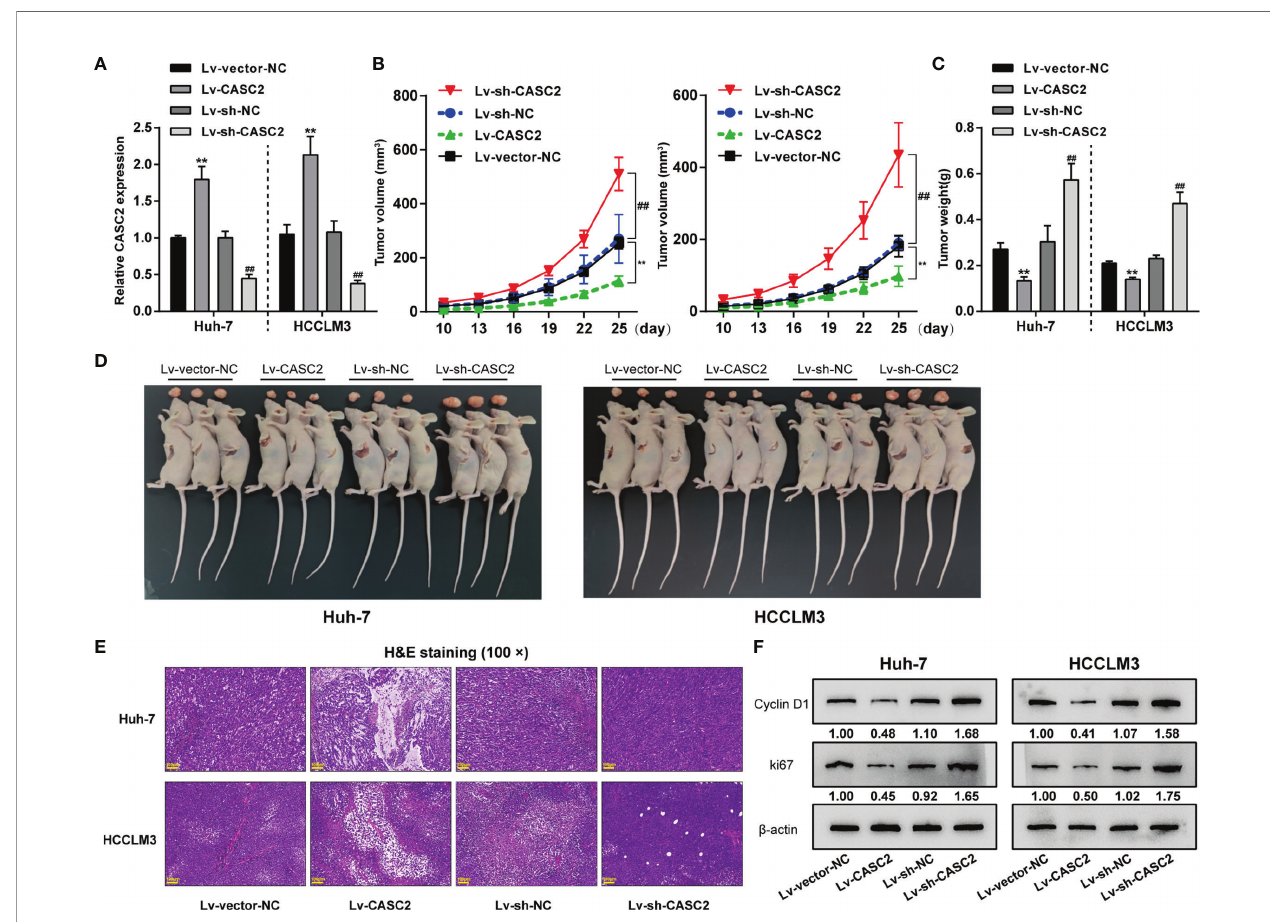
FIGURE 2 | In vivo effects of lncRNA CASC2 on Huh-7 cell tumor growth. (A) Subcutaneous xenotransplant tumor model was established in nude mice by injecting Huh-7 or HCCLM3 cells infected with human lncRNA CASC2-overexpressing lentivirus (lv-CASC2) or negative control lv-NC and CASC2-knockdown lentivirus (lv-sh- CASC2) or corresponding control (lv-sh-NC). The expression of lncRNA CASC2 in Huh-7 or HCCLM3 cells were examined by real-time qPCR. (B) Tumor volume was measured every 3 days from the 10th day after injection, when the tumor began to form. (C) On the 25th day, nude mice were sacri fi ced and the tumor weight was measured. (D) Images of the tumors in each group. (E) The histopathological characteristics of the tumors were examined by hematoxylin and eosin (H&E) staining. (F) The protein levels of proliferating markers in tumors were examined by Immunoblotting. **p < 0.01, compared with lv-vector-NC, ## p < 0.01 compared with Lv-sh-NC